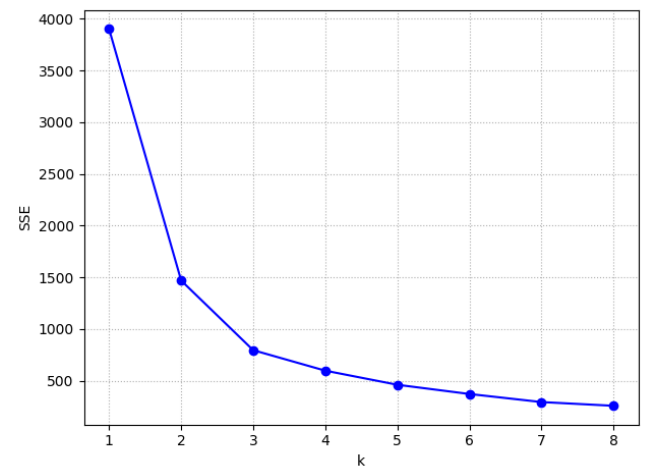
Figure 7. The relation curve between the SSE and k.